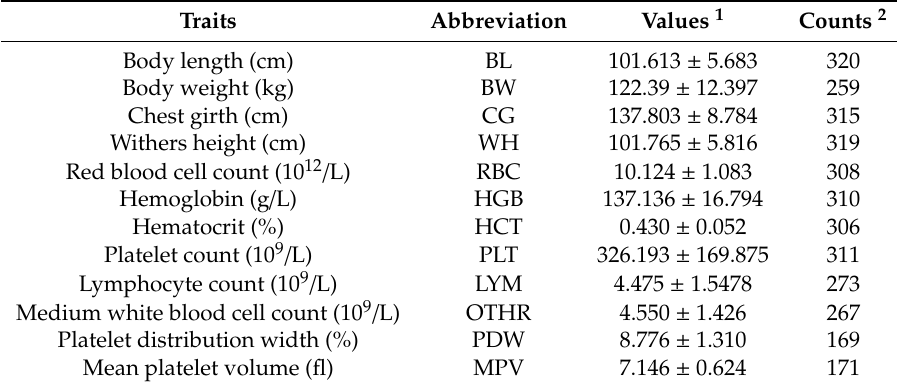
Table 2. Summary statistics of the 12 phenotypic traits.